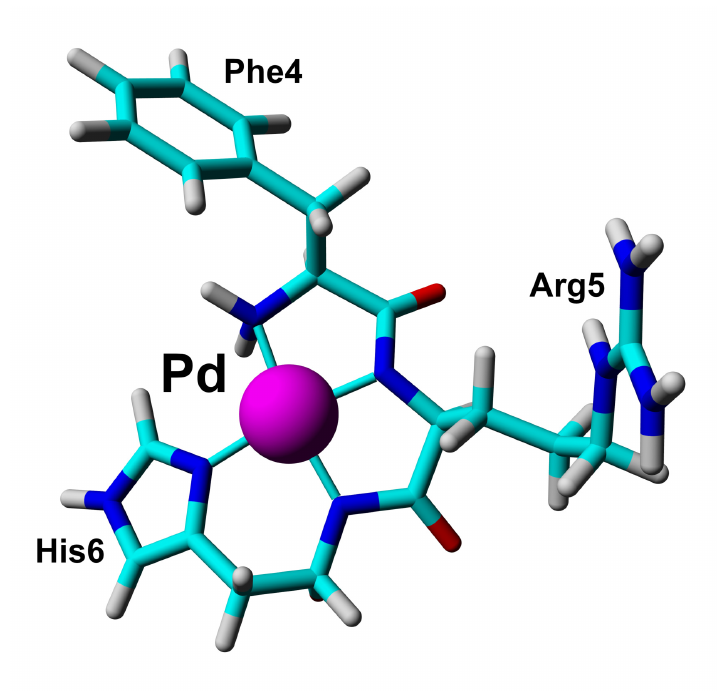
Figure 5. The 3D structure of Phe-Arg-His-amide (FRH) peptide represented the N-terminal ATCUN/NTS motif saturated with Pd(II) ion based on collected NMR constraints and crystallographic data available for GGH tripeptide